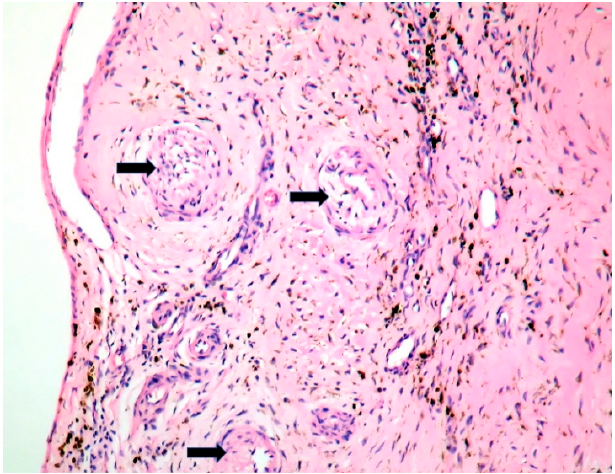
Figure 3. Tricuspid valve reparative changes; neoformation vessels with subocclusive intimal hyperplasia; siderophages after valve hemorrhage (Hematoxylin Eosin stain (HE) stain × 10).